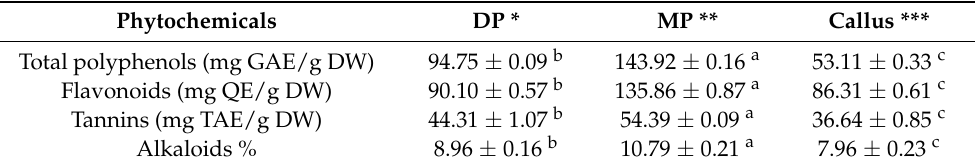
Table 4. Total polyphenols, flavonoids, tannins, and alkaloids in methanolic and ethanolic extracts from donor plant growing in soil in the botanical garden, ex-vitro-established micropropagated plants, and callus of R. chalepensis .